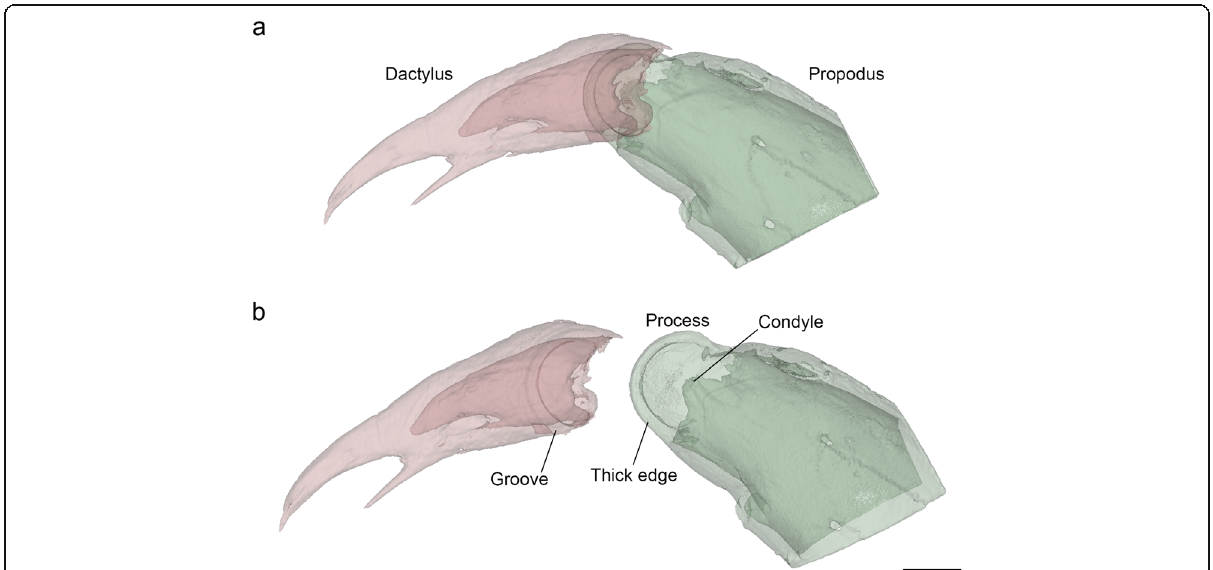
Fig. 2 3D reconstruction of the propodus-dactylus joint in Porcellio scaber. a A propodus-dactylus joint, reconstructed from serial optical sections, posterior view. The propodus is shown in green and the dactylus in red. The arthrodial membrane is not shown. b Propodus and dactylus shown separately. The thick edge of the process on the propodus fits in a groove on the dactylus. The propodus also forms a small condyle on the anterior side of the joint. Scale bar: 50 μ m are oriented at an angle of approximately 20° relative to process, this pattern is reversed: the convex surface of the sliding direction of the dactylus. The ridges on the the edge is smooth, and only its concave surface is tex- convex surface of the edge mirror the orientation of the tured (Fig. 4b). In P. scaber , the average spatial fre- ridges on its concave surface, forming a herringbone pat- quency of ridges was 610 ± 150 nm (mean ± standard tern on the dorsal part of the propodal process (Fig. 4c). deviation), and their height was 300 ± 40 nm. The ridges